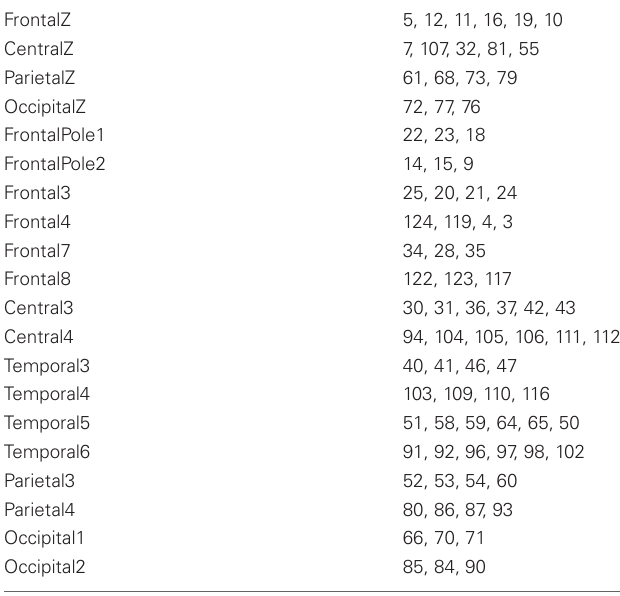
Table 1 | Virtual 10–20 electrodes for